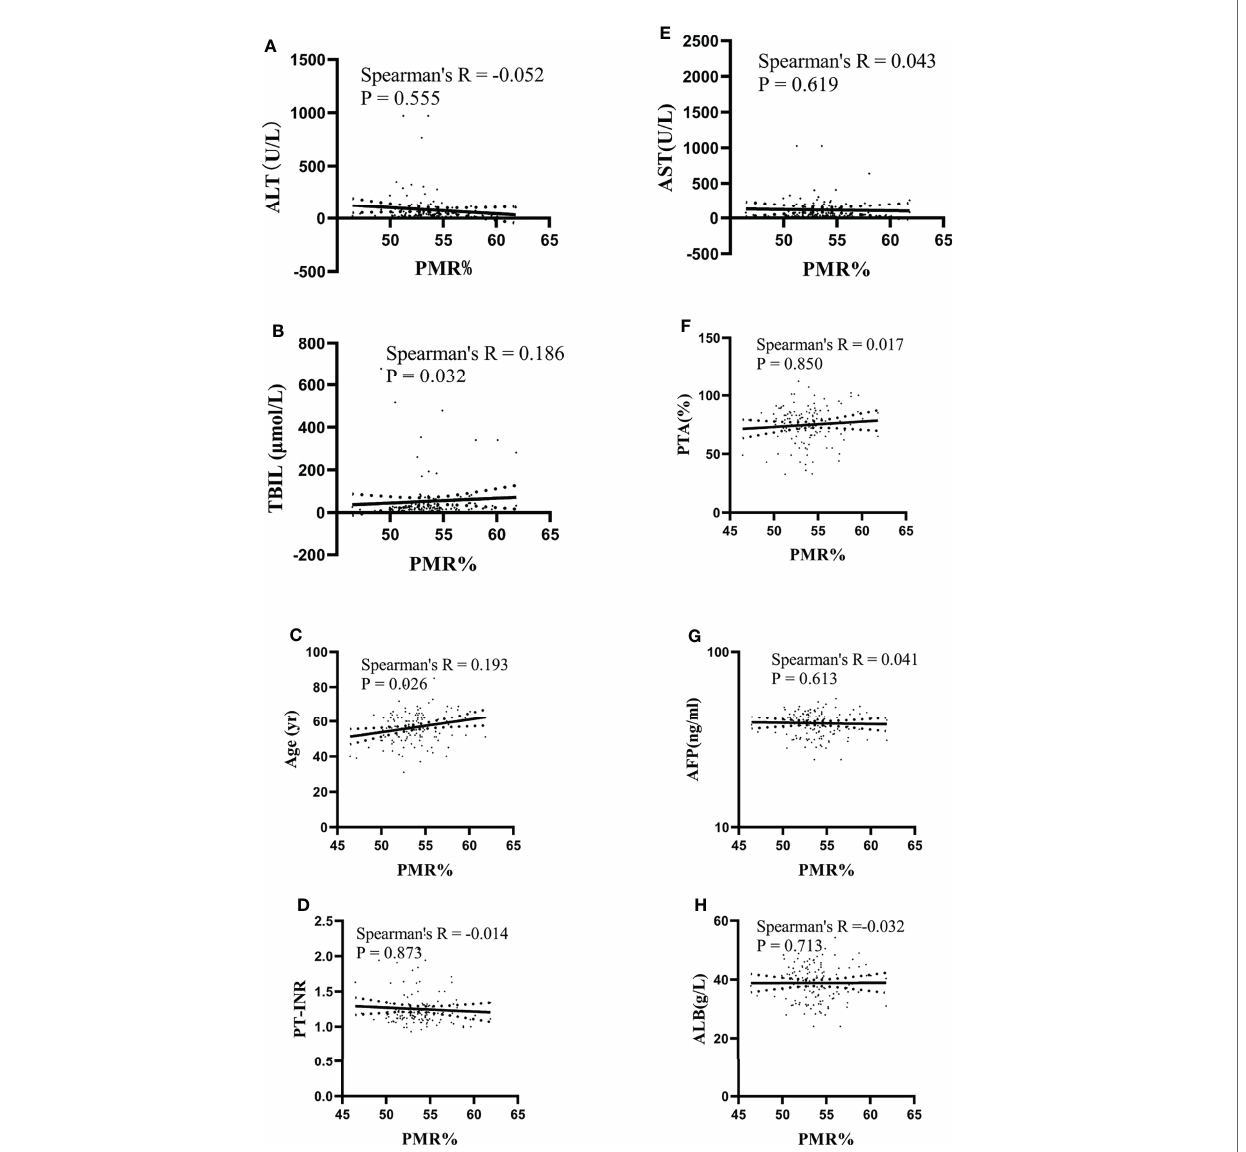
FIGURE 5 | Relationships between the IL-6 promoter methylation level and quantitative clinical data in the HCC group. (A) The PMR value of the IL-6 promoter was not signi fi cantly correlated with ALT in patients with HCC (Spearman ’ s R = -0.052, P = 0.555). (B) The PMR value of the IL-6 promoter was signi fi cantly correlated with TBIL in patients with HCC (Spearman ’ s R = 0.186, P = 0.032). (C) The PMR value of the IL-6 promoter was signi fi cantly correlated with age in patients with HCC (Spearman ’ s R = 0.193, P = 0.026). (D) The PMR value of the IL-6 promoter was not signi fi cantly correlated with PT-INR in patients with HCC (Spearman ’ s R = -0.014, P = 0.873). (E) The PMR value of the IL-6 promoter was not signi fi cantly correlated with AST in patients with HCC (Spearman ’ s R = 0.043, P = 0.619). (F) The PMR value of the IL-6 promoter was not signi fi cantly correlated with PTA in patients with HCC (Spearman ’ s R = 0.017, P = 0.850). (G) The PMR value of the IL-6 promoter was not signi fi cantly correlated with AFP in patients with HCC (Spearman ’ s R = 0.041, P = 0.613). (H) The PMR value of the IL-6 promoter was not signi fi cantly correlated with ALB in patients with HCC (Spearman ’ s R =-0.032, P = 0.713).